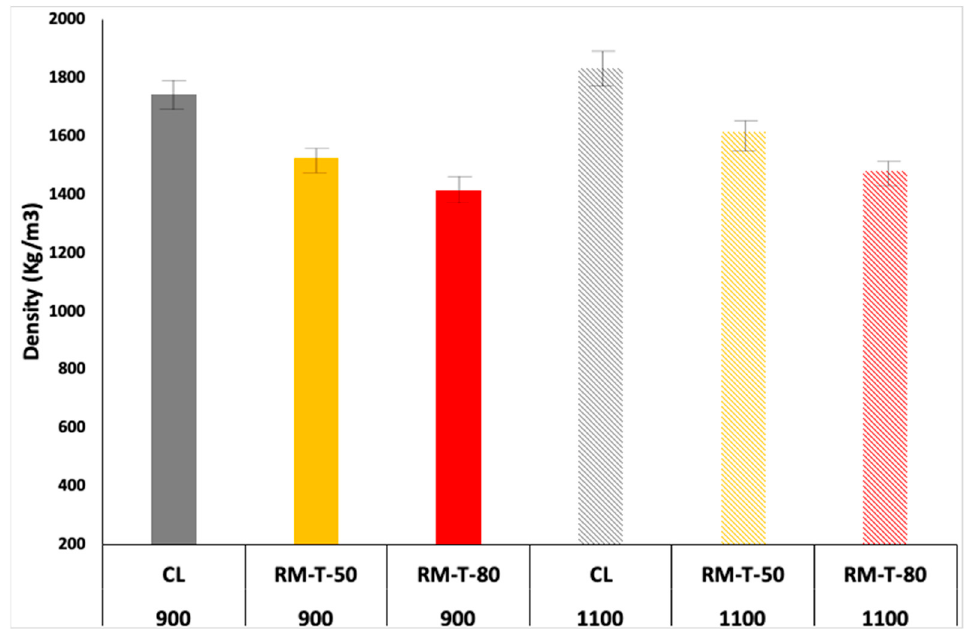
Figure 5. Density of samples after the sintering process.